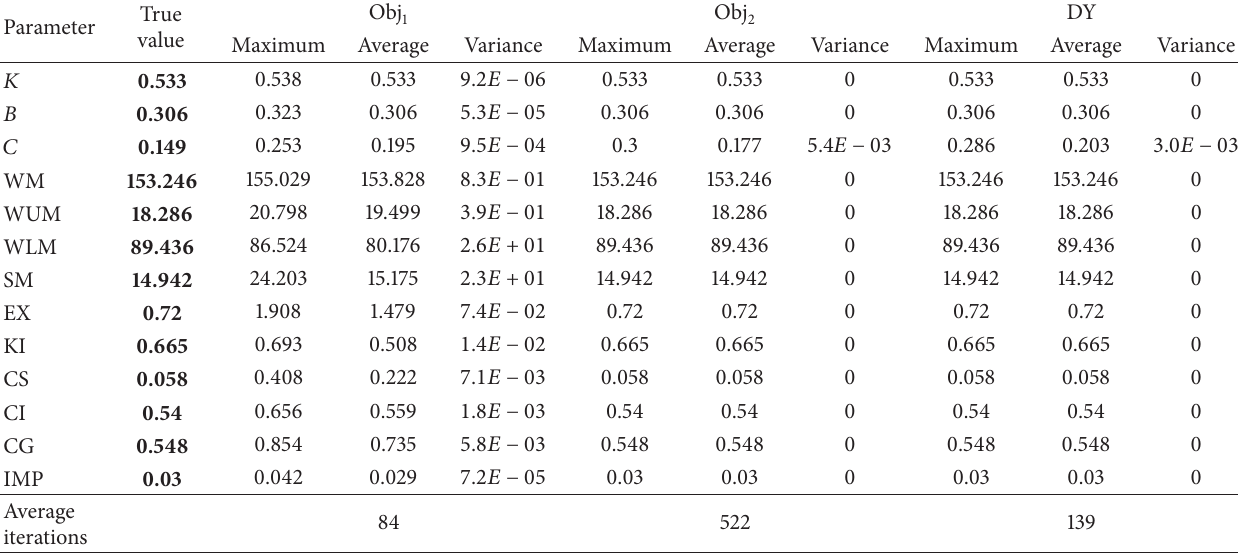
Table 5: Characteristics of the optimization results for the daily rainfall-runoff